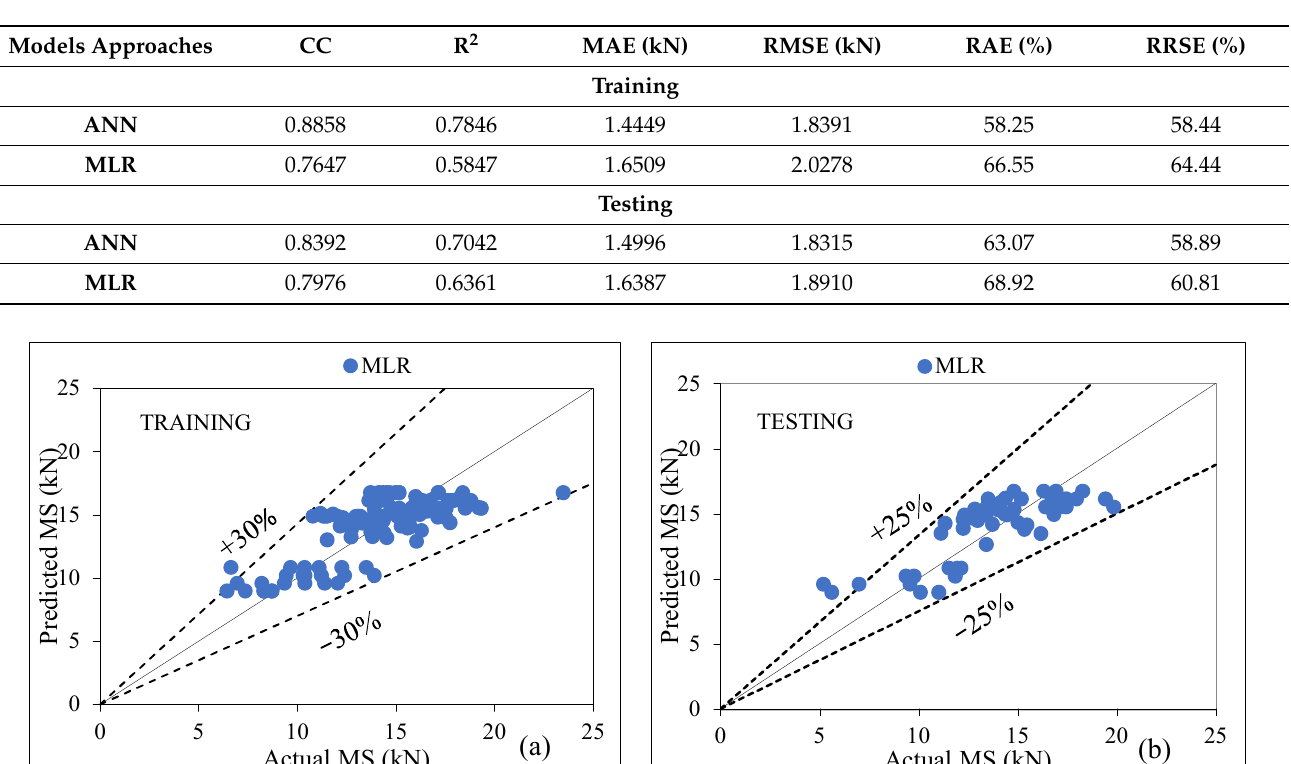
Figure 8. ( a , b ). Agreement graph showing actual vs. predicted values of MS by using an RT-based model for both stages. Table 12. Performance evaluation ANN and MLR model.